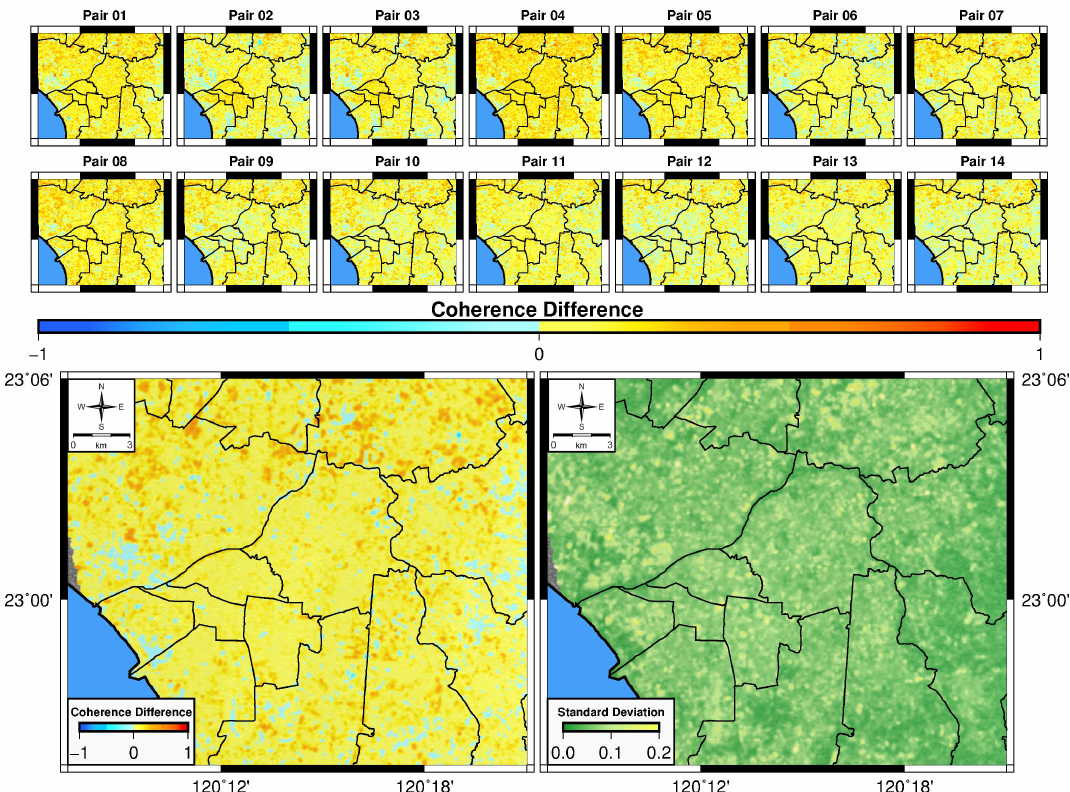
Figure 6. The background coherence difference results for ascending orbits. The top two rows are the time series of coherence differences for the ascending background image pairs. The subfigure in the lower-left quarter displays the mean values of coherence differences for ascending background image pairs. The subfigure in the lower-right quarter shows the values of standard deviations for ascending background image